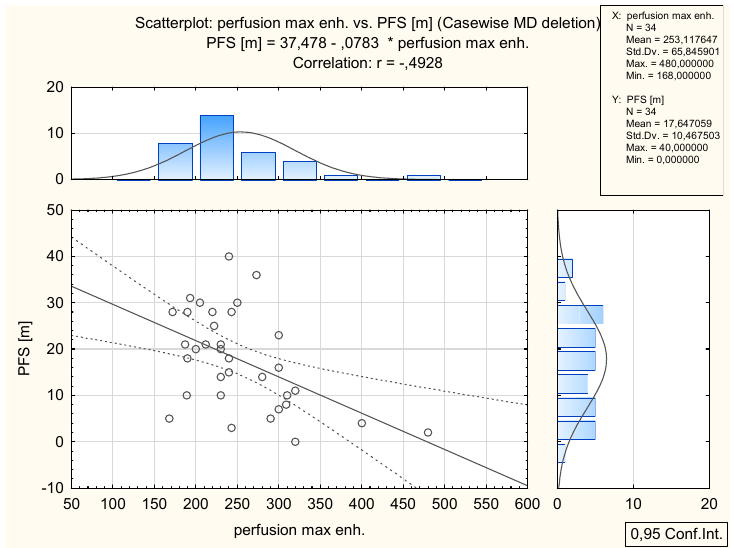
Figure 10. Inverse correlation between the values of Perf. Max. En. and PFS (months) in 34 patients who relapsed. Above: the distribution of Perf. Max. En. values; on the right: distribution of